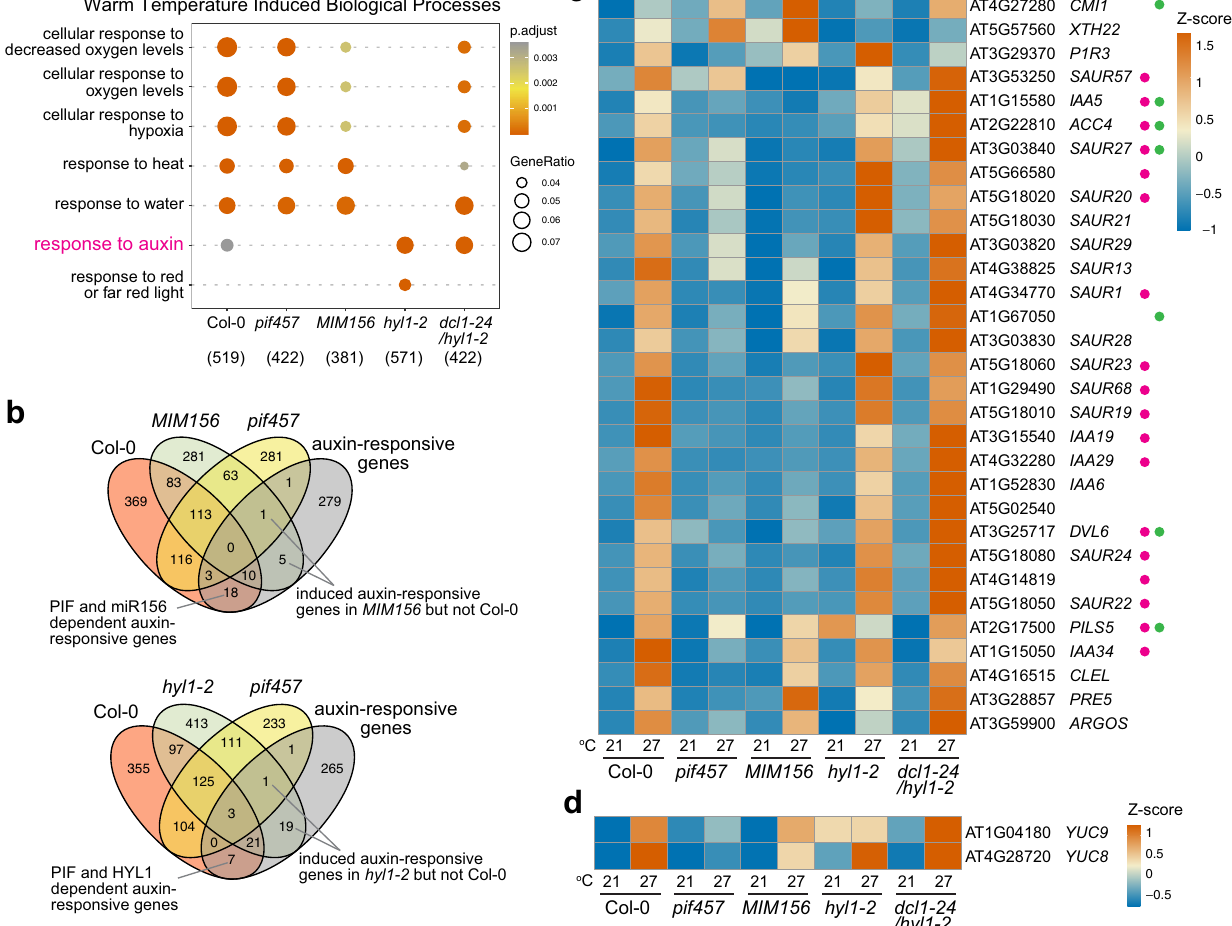
Col-0, pif457 , hyl1-2 , and MIM156 . c Heatmapshowing therelative expressionlevels of the 31 warm-temperature-upregulated auxin-responsive genes in Col-0, pif457 , MIM156 , hyl1-2 ,and dcl1-24/hyl1-2 at 21°Cand 27°C.The magentadotsindicatethe 18 auxin-responsive genes thatare dependent on both PIFs and miR156. The green dots indicate the 7 auxin-responsive genes that are dependent on both PIFs and HYL1. d Heatmapshowingtherelativeexpressionlevelsof YUC8 and YUC9 inCol-0, pif457 , MIM156 , hyl1-2 , and dcl1-24/hyl1-2 at 21°C and